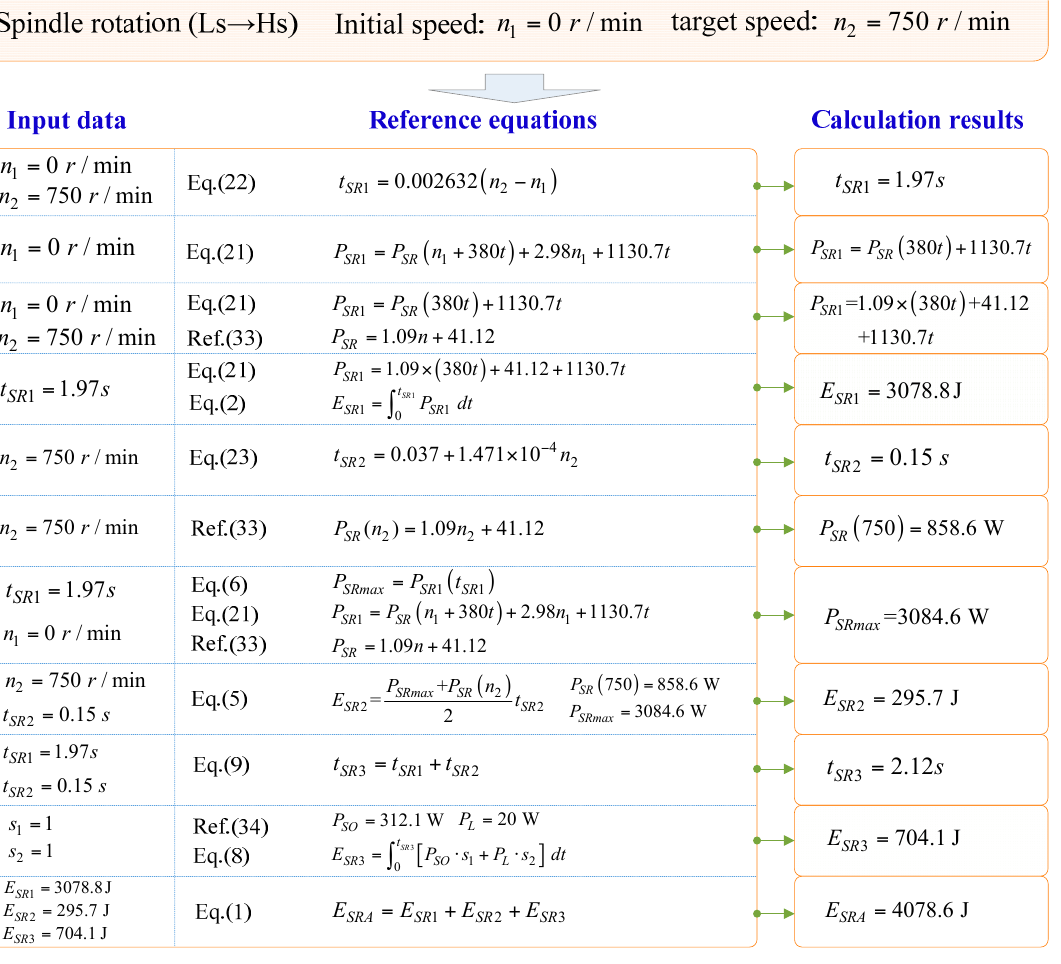
Figure 13. The input data, reference equations and calculation results of intermediate variables are clearly shown in this figure.